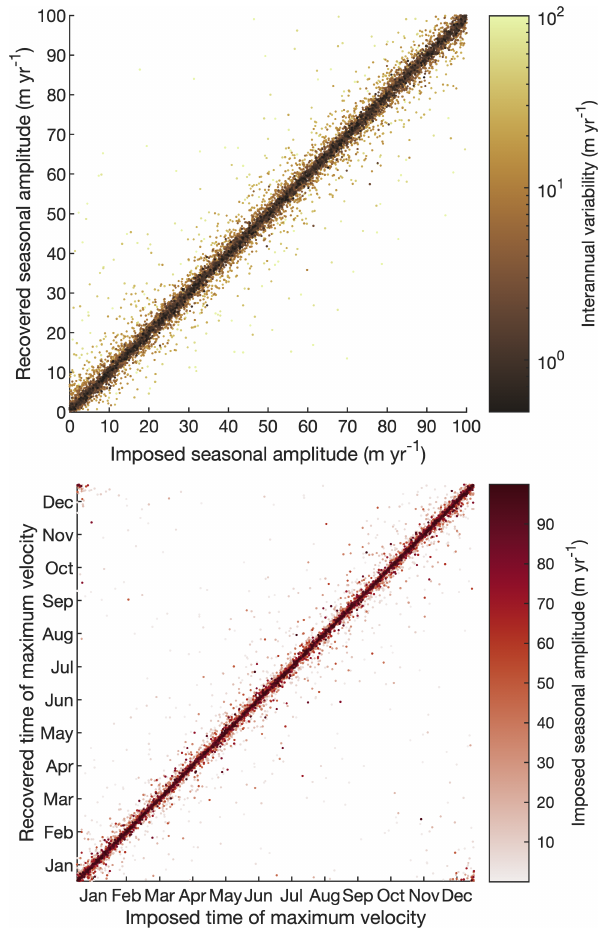
Figure 6. Pan-Antarctic seasonal signal recovery. Following the pa- rameters of the final test in Table 1, we examine the performance of our method using the complete distributions of Antarctic Landsat image acquisition times, ITS_LIVE velocity errors, and measured Antarctic interannual ice velocity variability. Among the results where 500 or more image pairs were used to analyze the time series, amplitude uncertainty was found to be 1.4myr − 1 , and phase uncer- tainty is 2d visual clarity. Only 10000 randomly selected results are shown of the 100000 tests we performed for overall Antarctic pa- rameter